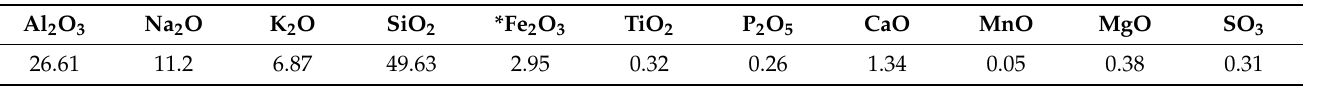
Figure 3. X-ray diffraction pattern of the nepheline concentrate sample. Patterns of nepheline, natrolite, microcline, biotite, titanite, and pyroxene are given from Ruff database. Table 1. Nepheline concentrate sample composition according to XRF data in terms of oxides wt.%.